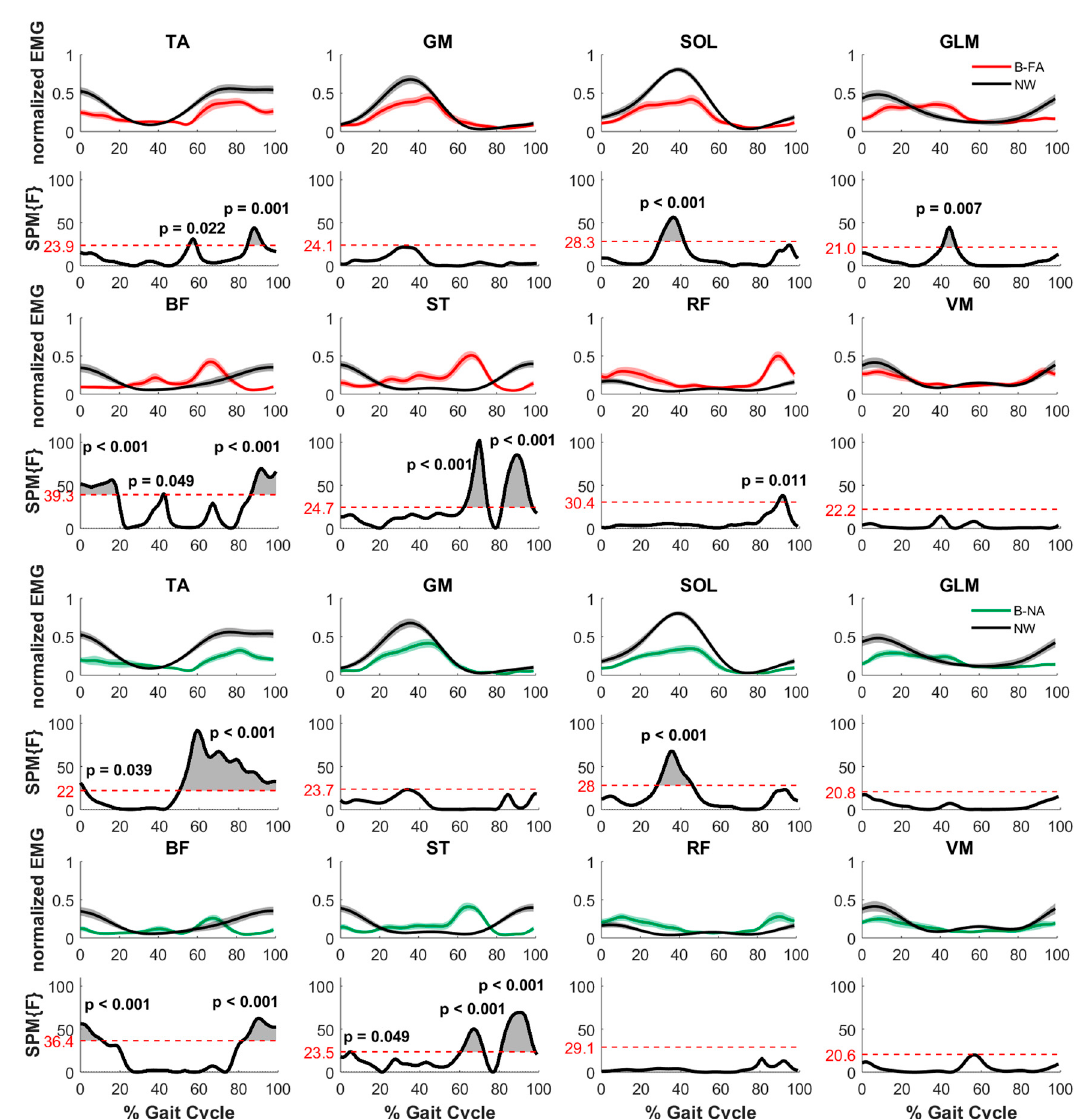
Figure 6. Rows 1, 3, 5, and 7: Comparison between normal walking (black lines) and bilaterally assistive (B-FA) walking with the Ekso (top panel, rows 1–3, red lines) and unassisted (B-NA) walking with the Ekso (low panel, rows 5–7, green lines) (mean ± SE). We considered the following muscles: muscles tibialis anterior (TA), gastrocnemius medialis (GM), soleus (SOL), rectus femoris (RF), vastus medialis (VM), semitendinosus (ST), biceps femoris (BF), and gluteus medius (GLM). The lines were obtained by averaging the strides performed with crutches and walkers as well as the strides started with the left and right leg. Rows 2, 4, 6, 8: panels show the SPM{F} statistic as a function of the percentage of gait cycle. The threshold for significance is indicated in red.